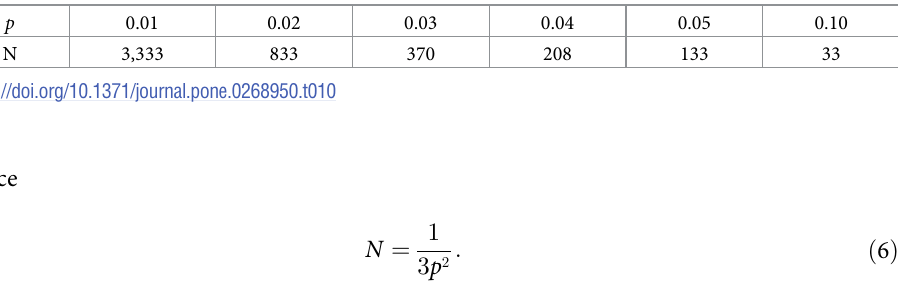
Table 10. The (minimal) sample size N with respect to the relative standard error p